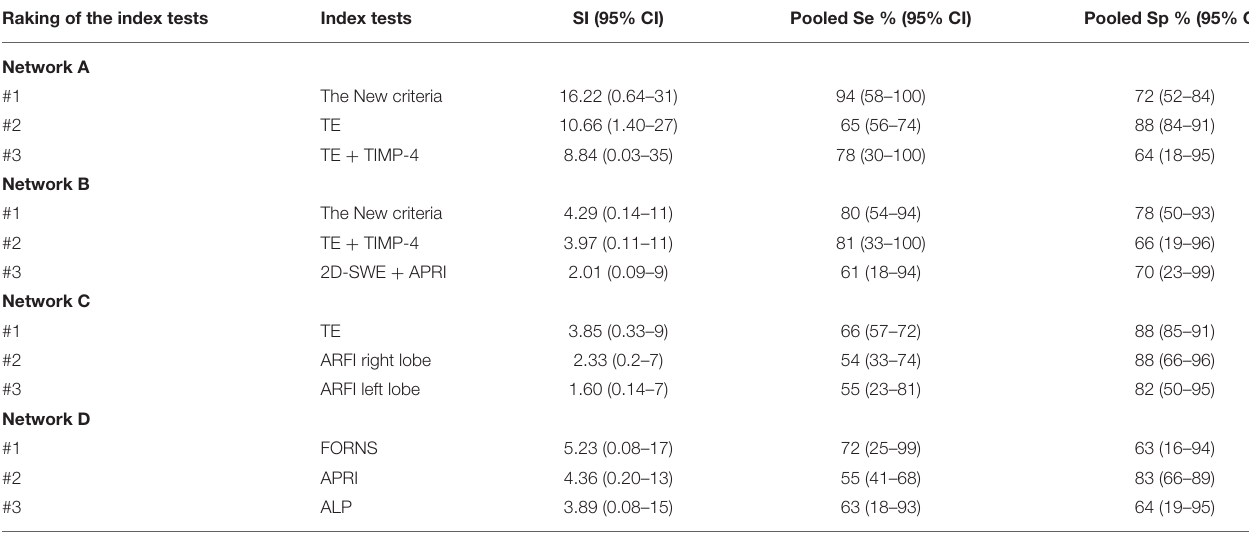
TABLE 3 | Ranking of the top three index tests by superiority indices. Raking of the index